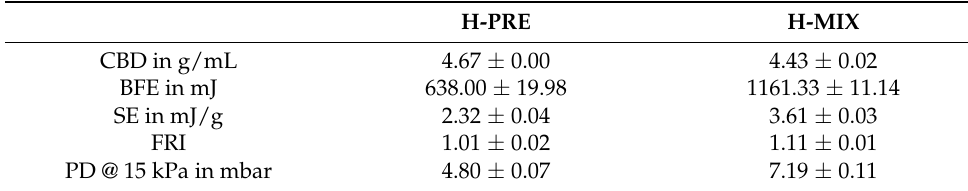
Figure 5. Pressure drop across the powder bed of H-PRE and H-MIX for different applied nor- mal stresses. Table 4. Flowability characteristics of H-PRE and H-MIX